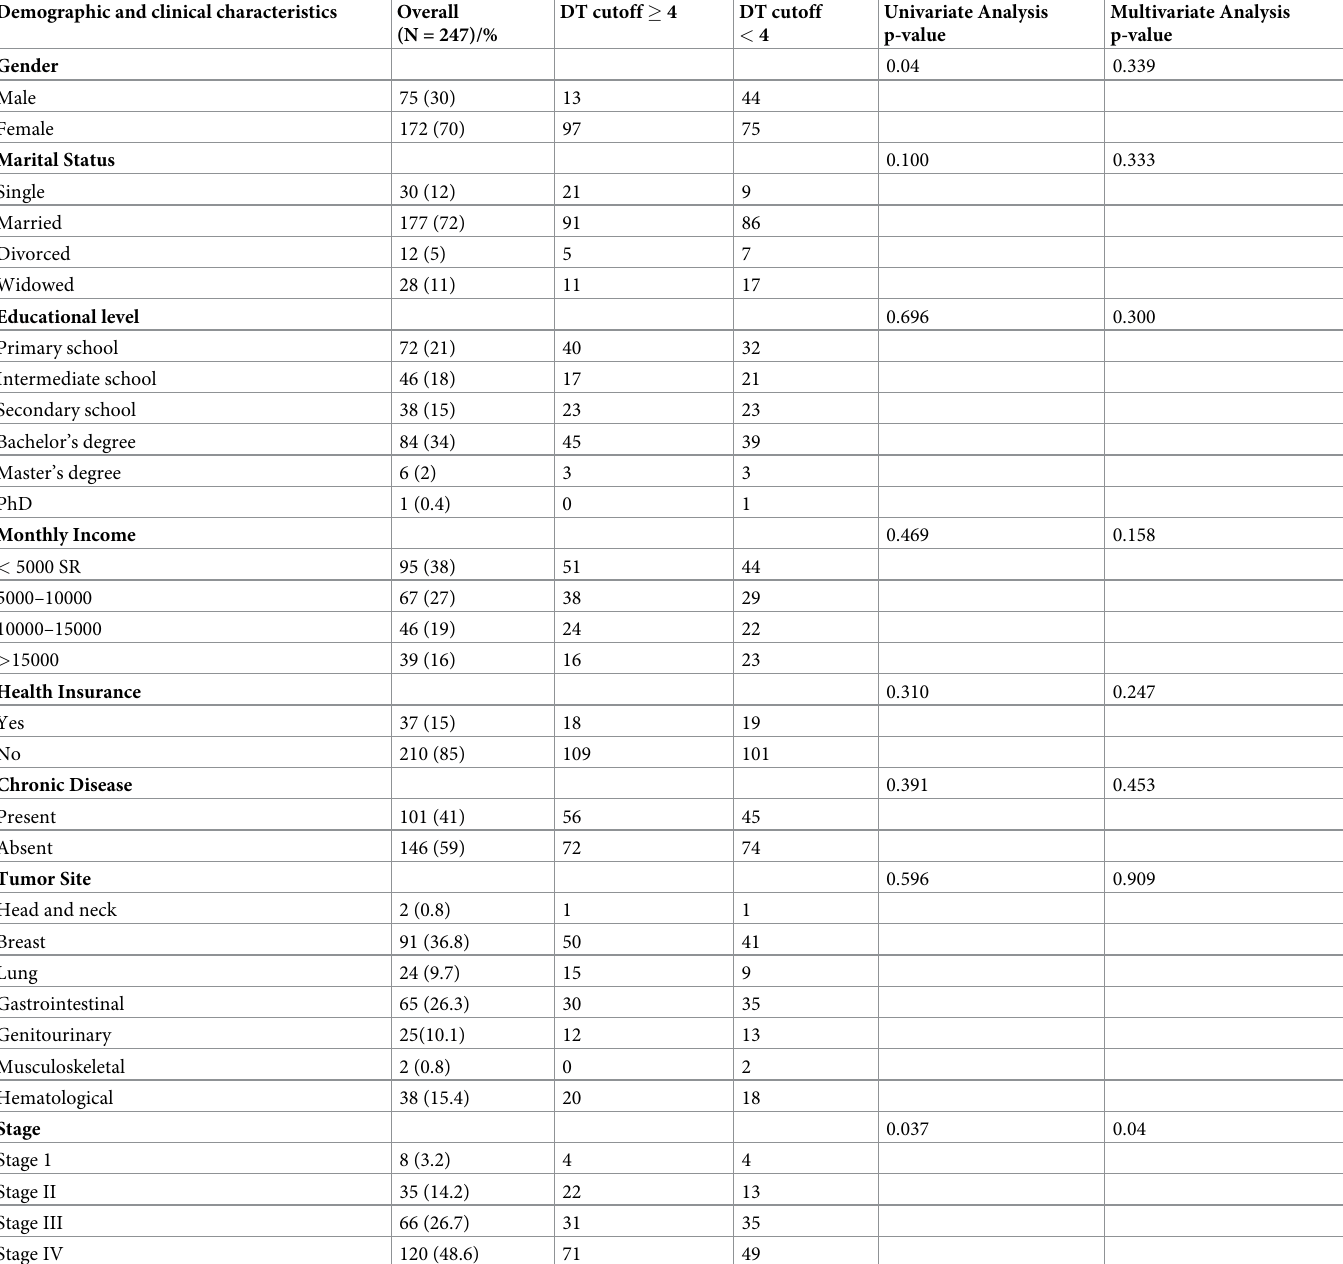
Table 2. Univariate and multivariate regression analyses of the association between the Distress Thermometer (DT) score � 4 and the sociodemographic and clini- cal characteristics of 247 cancer patients. Demographic and clinical